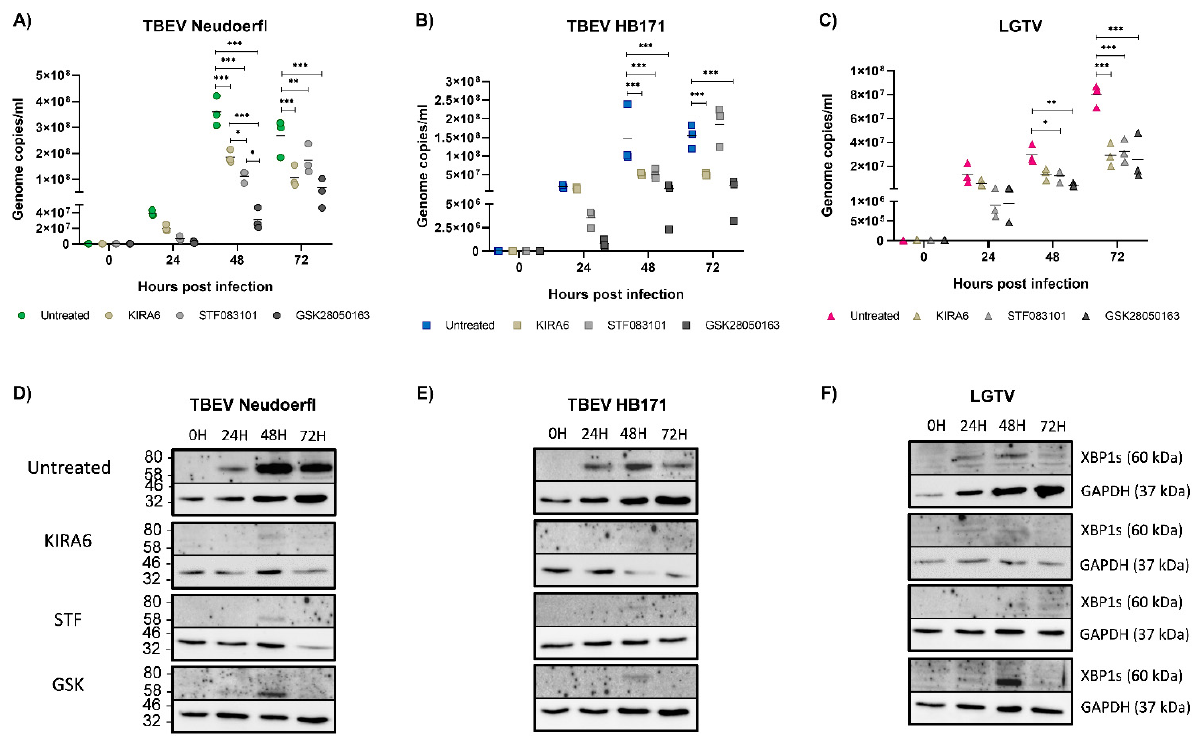
Figure 5. Infection experiments in the astrocyte cell line SNB19 were performed as described in Figure 4. Infections of untreated cells with Neudoerfl are shown in green ( A ), HB171 in blue ( B ) and LGTV in pink ( C ). Infections of cells pretreated with KIRA are shown in light brown, STF in light grey and GSK in dark grey, respectively. All infections were performed in triplicates and repeated three times. Statistical analyses were performed by 2-way ANOVA with Tukey’s multiple comparison test, * p < 0.033, ** p < 0.002, *** p < 0.001. Cell lysates were analyzed by Western blot for XBP1 expression after infection with Neudoerfl ( D ), HB171 ( E ) or LGTV ( F ). GAPDH expression was analyzed as a housekeeping control. A representative blot is shown. kDa, kilodalton.